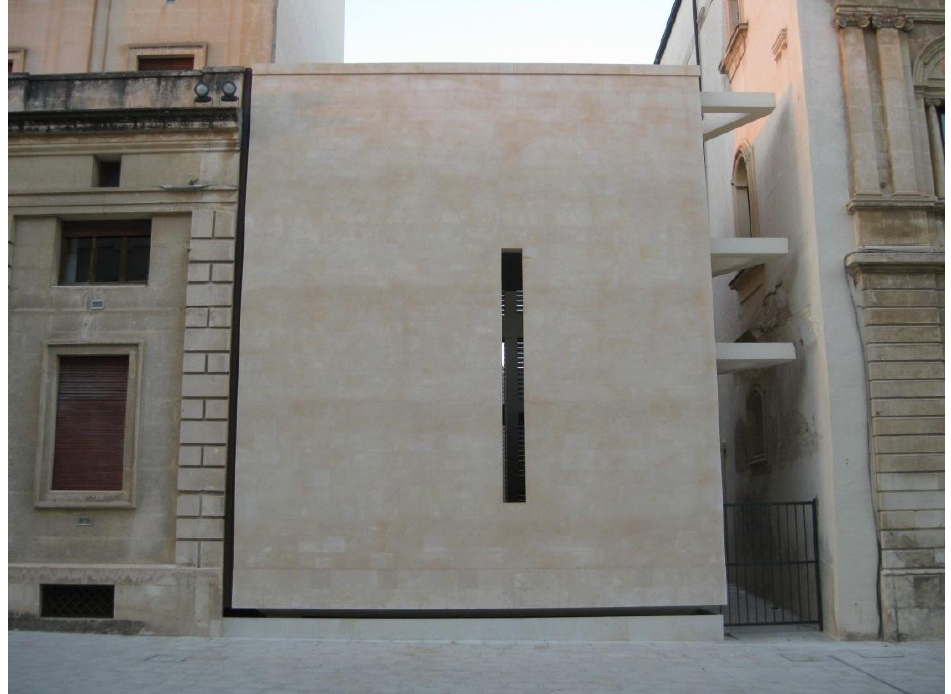
Figure 11. An example of contemporary stone architecture in Ortigia: Access Pavilion to